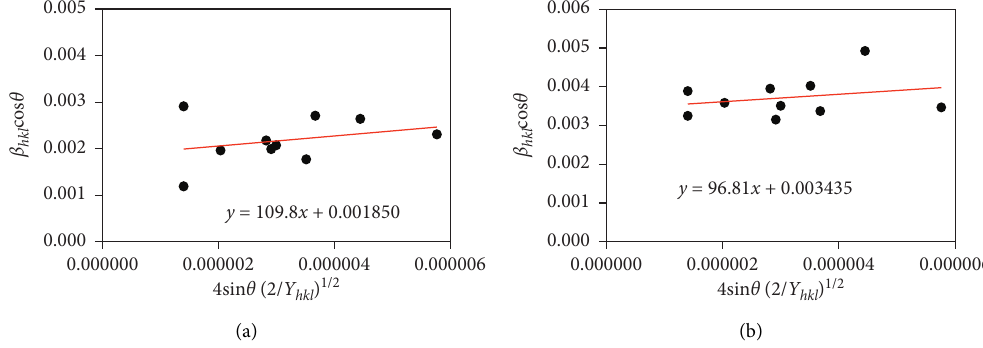
Figure 4: UDEDM plot for Al 2 O 3 /10wt. % SiC: (a) electrical resistance heating sintering; (b) microwave